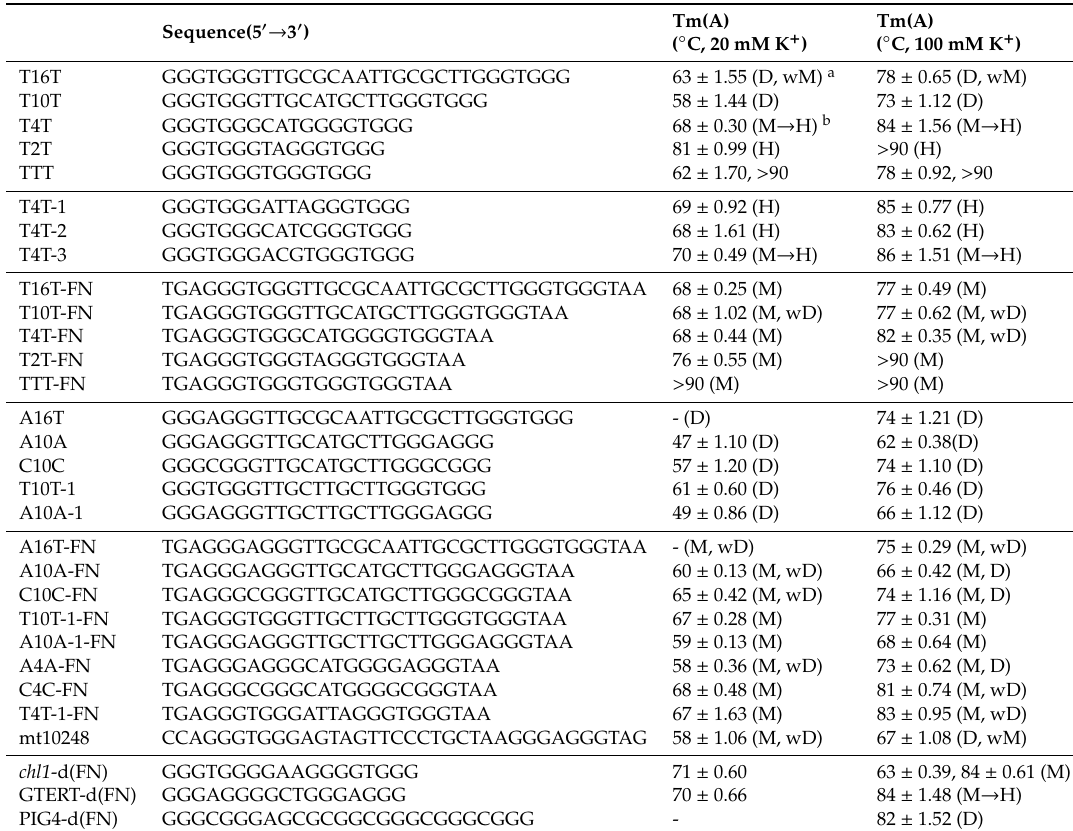
Table 1. Sequences studied in this work and their melting temperatures and conformations in the presence of 20 and 100 mM K + ,